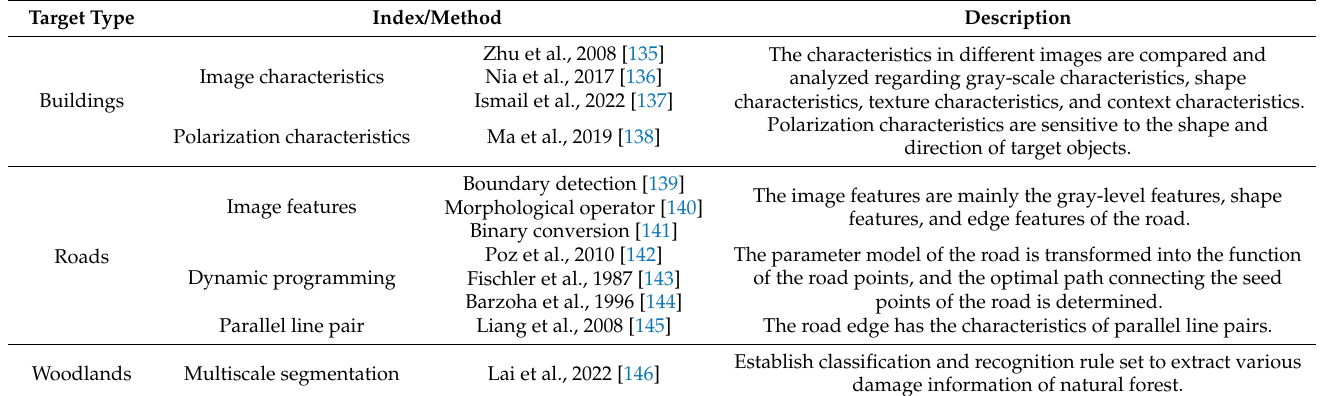
Table 10. Target detection approaches for disaster-bearing